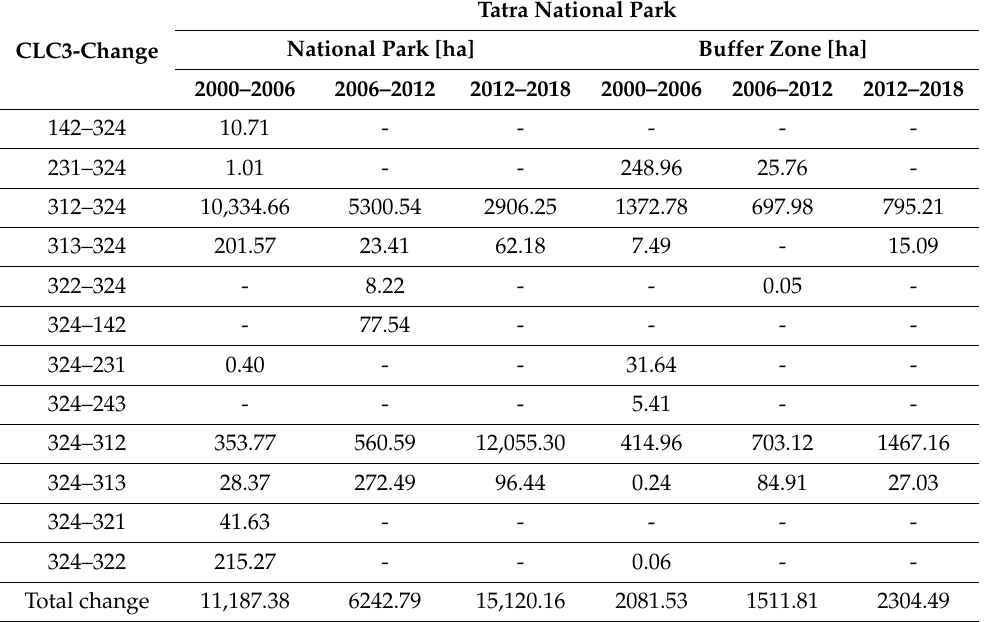
Table 4. Development of CLC-Changes in NAPALT (in the national park and its buffer zone sepa- rately).